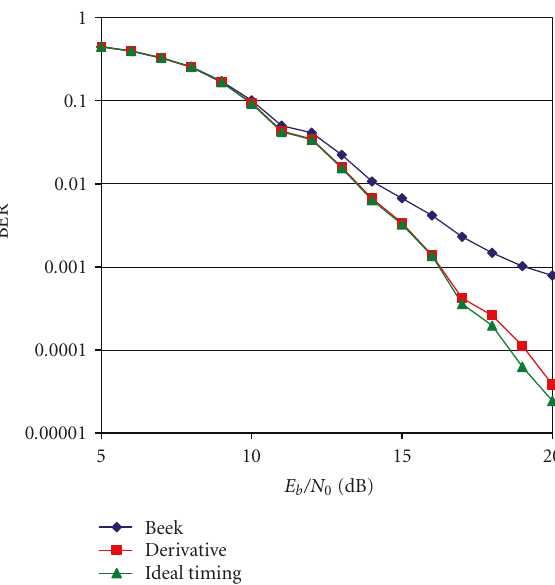
Figure 7: Error performance as a function of E b /N 0 .